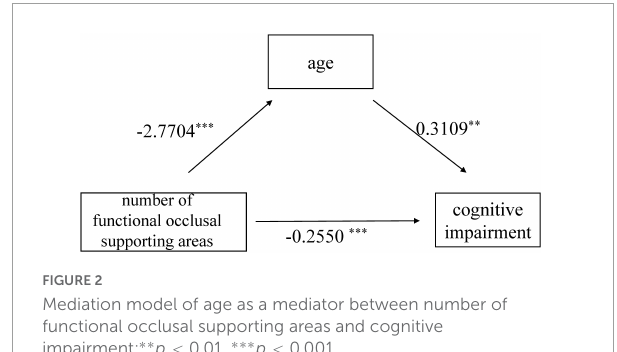
FIGURE2 Mediation model of age as a mediator between number of functional occlusal supporting areas and cognitive impairment; ∗∗ p < 0.01, ∗∗∗ p <